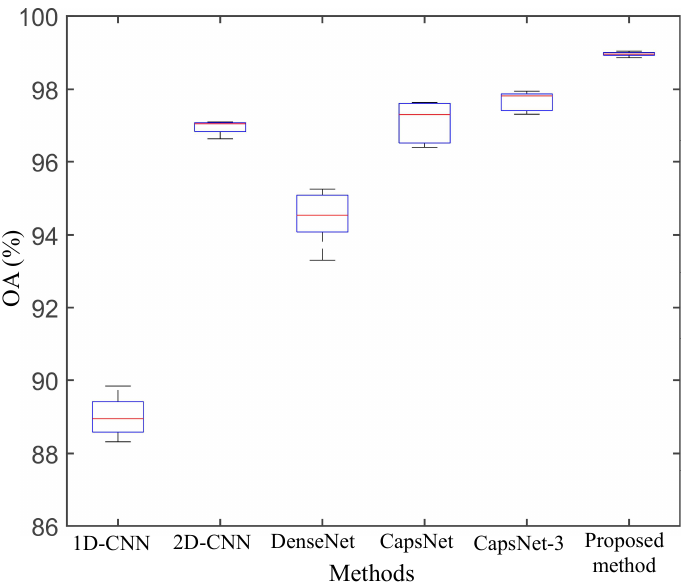
Figure 9. Box plot of the five repeated experimental results on AIRSAR Flevoland